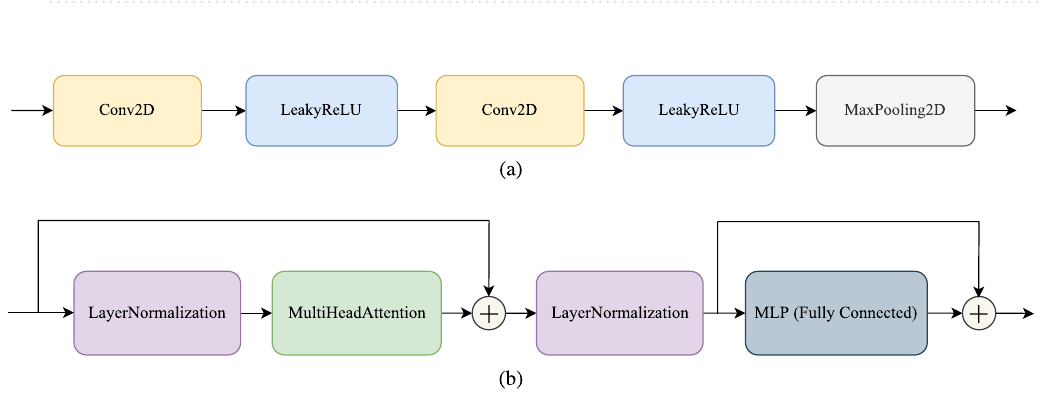
Figure 2. Sample images from Rice Leaf Disease Dataset: ( a ) bacterial leaf blight, ( b ) brown spot, and ( c ) leaf smut.